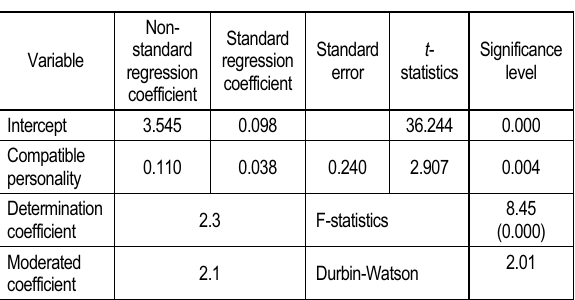
Table 2. Compatible personality has a